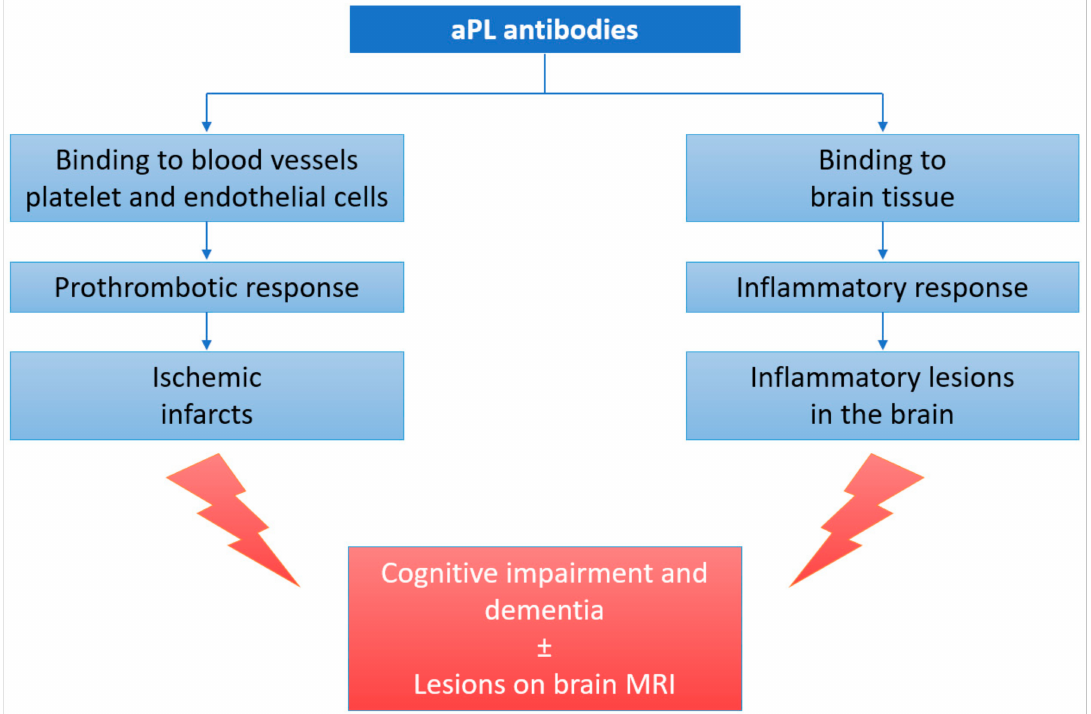
Figure 1. Pathophysiology of cognitive impairment in aPL carriers and APS patients. aPL—anti- phospholipid antibodies; MRI—magnetic resonance